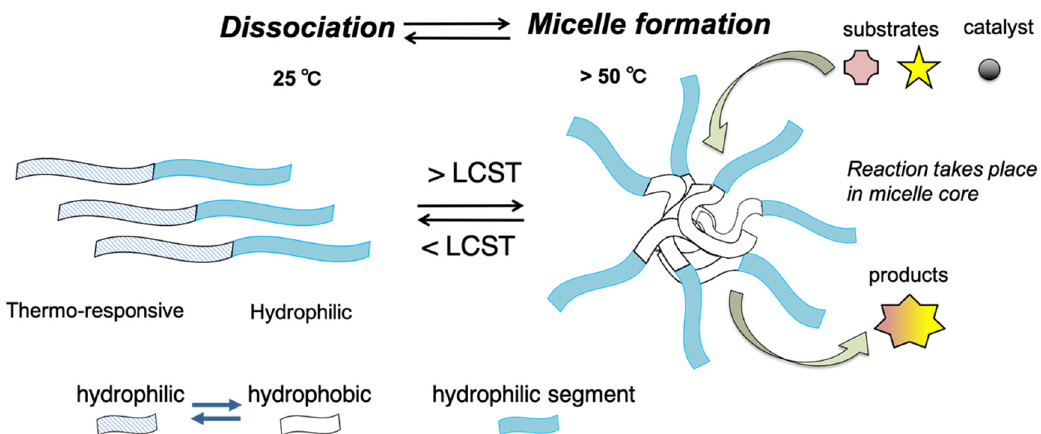
Figure 1. Thermoresponsive micelle formed by diblock copolymers.